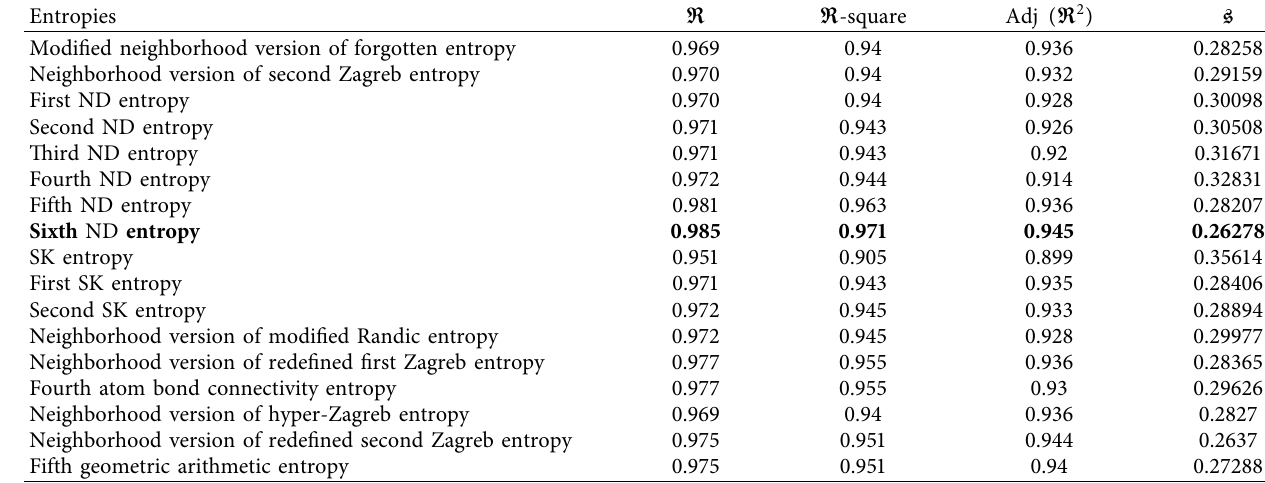
Table 8: The significant LRM: log ( P ) of benzene derivatives on indices.